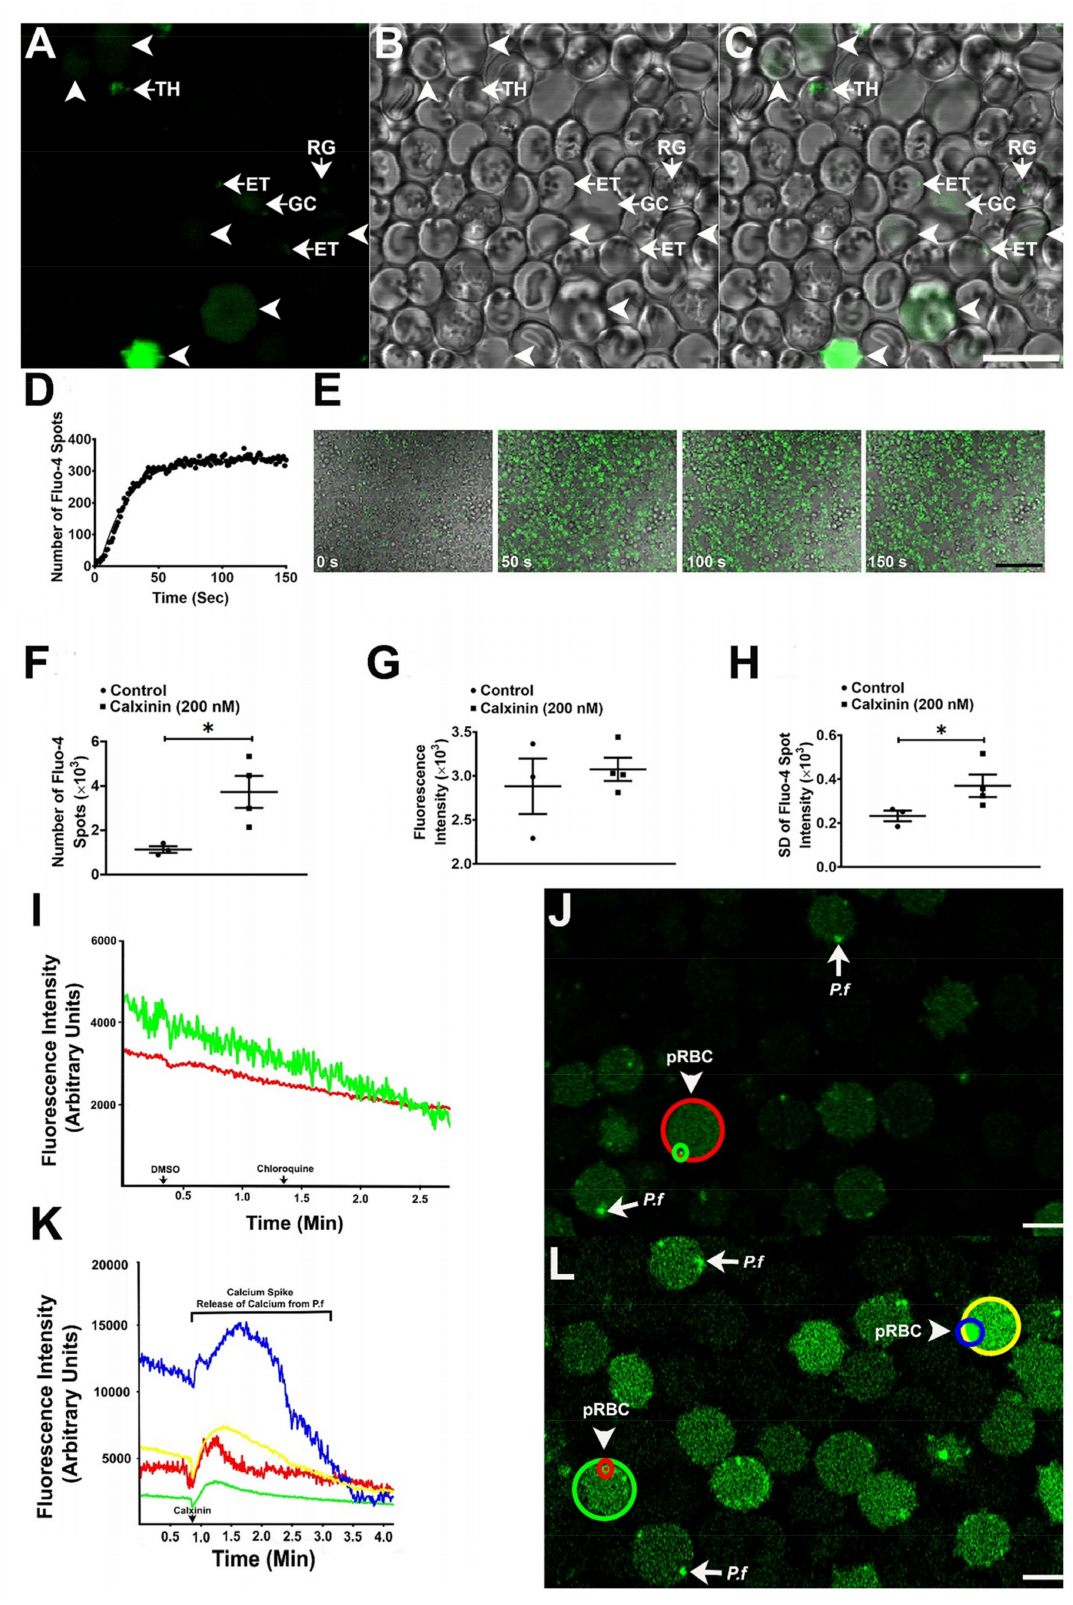
Figure 5. Confocal and live imaging of Fluo-4 AM-loaded uninfected and infected RBCs (2 to 3% parasitemia). ( A ) Fluo-4 AM fluorescence in uninfected and infected RBCs. ( B ) Visualization of